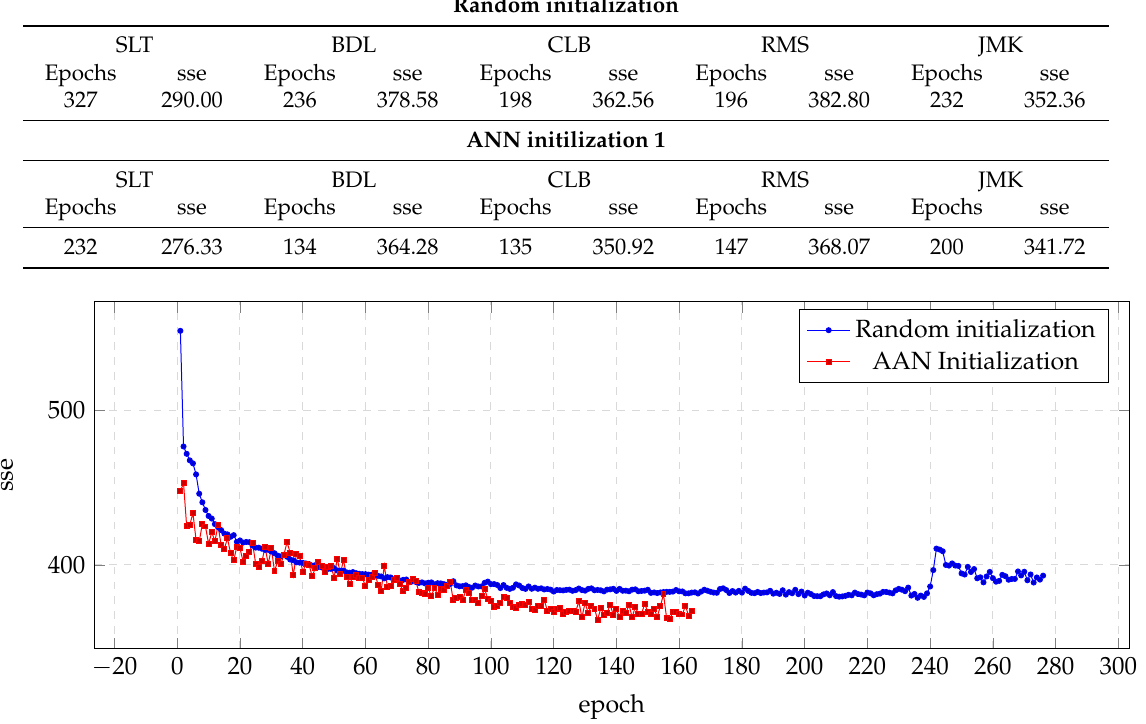
Figure 1. Evolution of the sse value for the validation set during the training process of the BDL